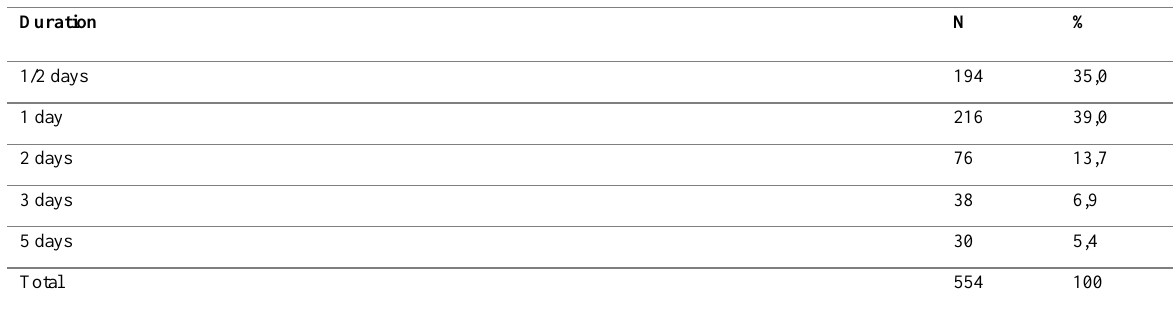
Table 17: Duration of In-Service Trainings